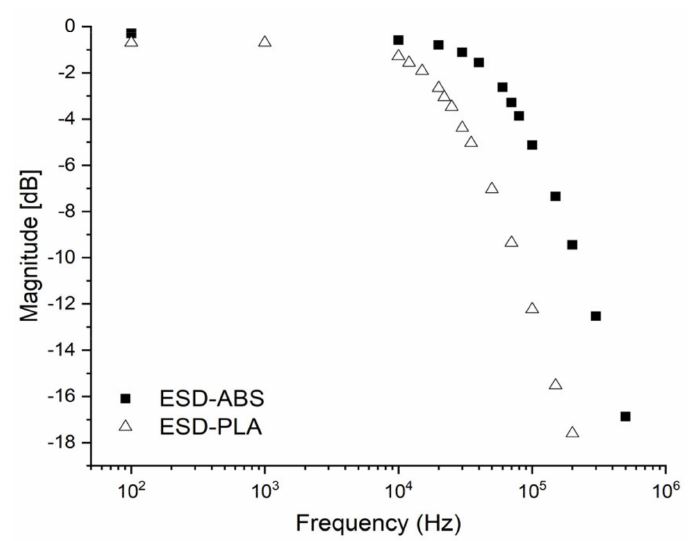
Figure 6. On the Bode diagram, the attenuation values can be observed. The length of test specimens was 100 mm, printed with a 400 µ m layer